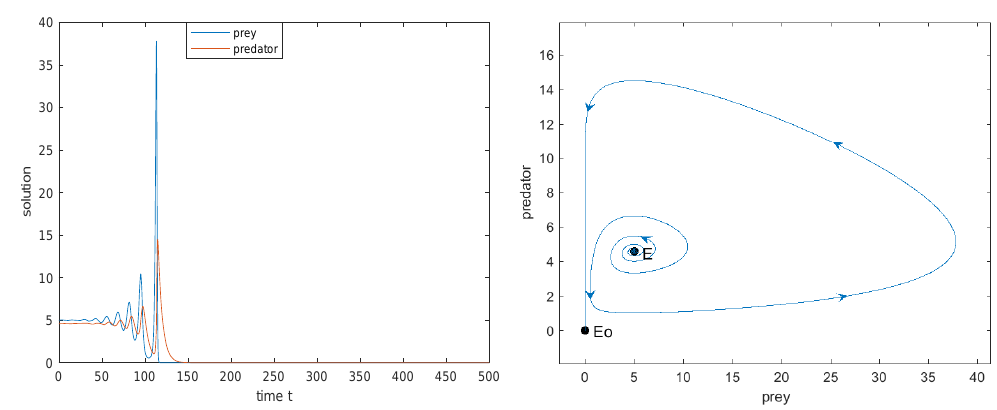
= 0.5222, the subcritical Hopf bifurcation occurs at E Figure 7. τ = τ + 0 ( φ ) = ( 5,4.2 ) . 1 , φ 2 ) = ( 0.5222, 14.6232 ) , E 3. Taking τ = 2.7 ∈ ( τ + , τ − 0 0